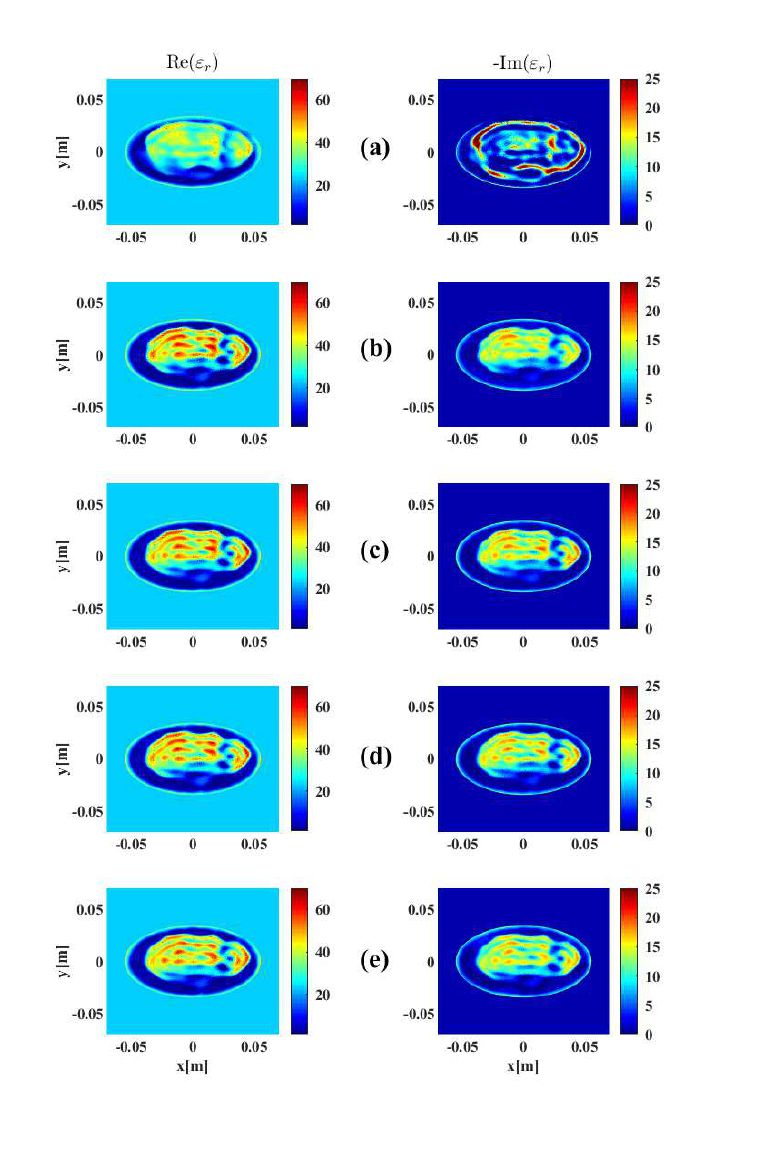
Figure 11. Final results of DGM-CSI frequency-hopping and frequency-cycled complex dielectric property reconstruction of open-boundary Category D synthetic breast model using 1.0–3.0 GHz data: ( a ) Scenario G—without tissue-dependent mapping at 400 iterations per frequency terminating after first inversion of 3.0 GHz (5% noise), ( b ) Scenario H—with tissue-dependent mapping and stopping criteria in place at 3% noise, ( c ) Scenario I—with tissue-dependent mapping and stopping criteria in place at 5% noise, ( d ) Scenario J—with tissue-dependent mapping and stopping criteria in place at 7.5% noise, ( e ) Scenario K—with tissue-dependent mapping and stopping criteria in place at 10% noise. See Table 3 for further